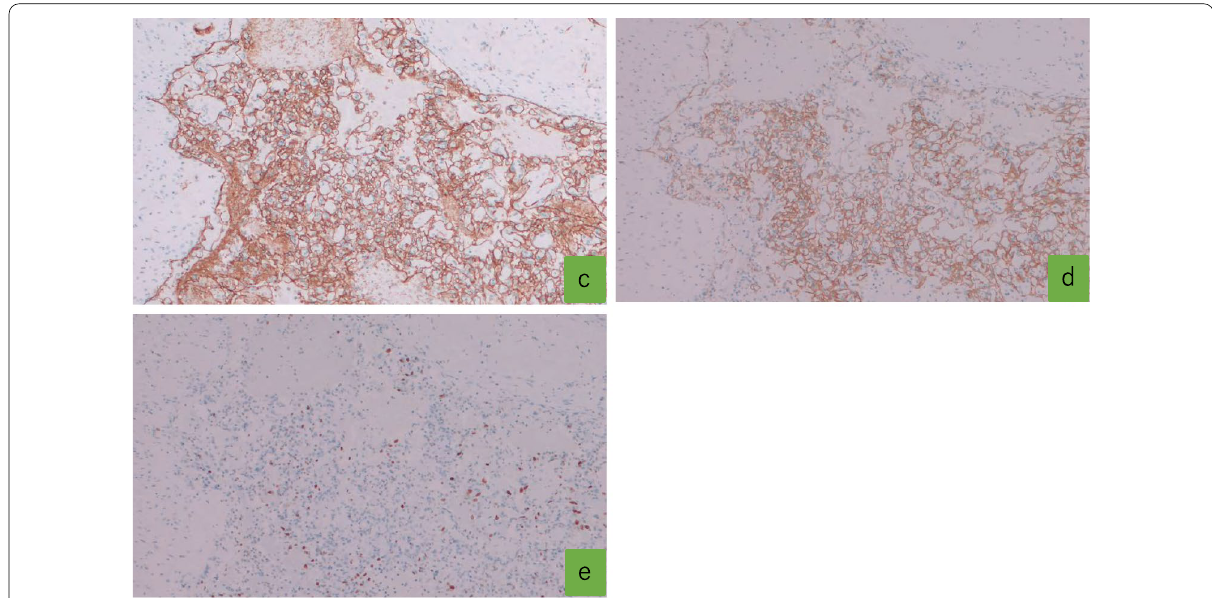
Fig. 6 Histological staining for CD31 ( c ), CD34 ( d ) and Ki-67 ( e ), 100 monolayer endothelial growth. Ki-67 staining did not show a high rate of positive cell